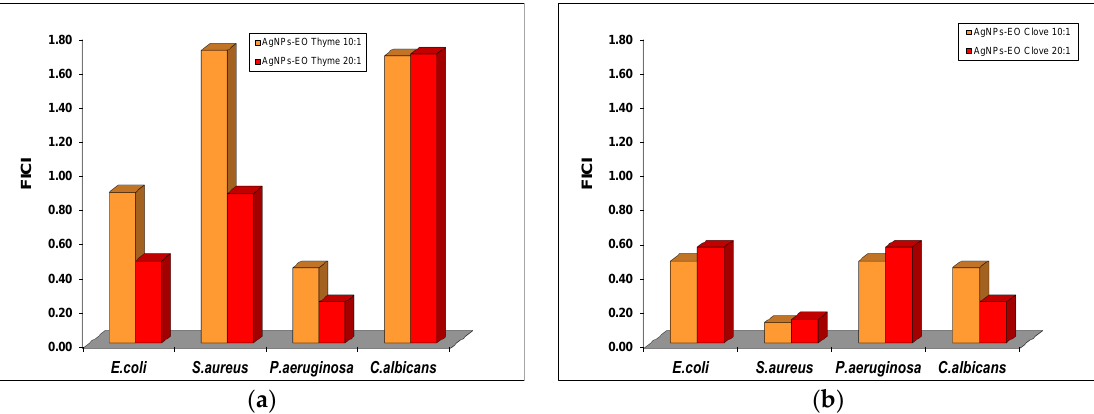
Figure 8. The variation of the fractional inhibitory concentration index (FICI) of bare AgNPs–essential oils (Eos) at various ratios. ( a ) Thyme oil; ( b ) Clove oil.